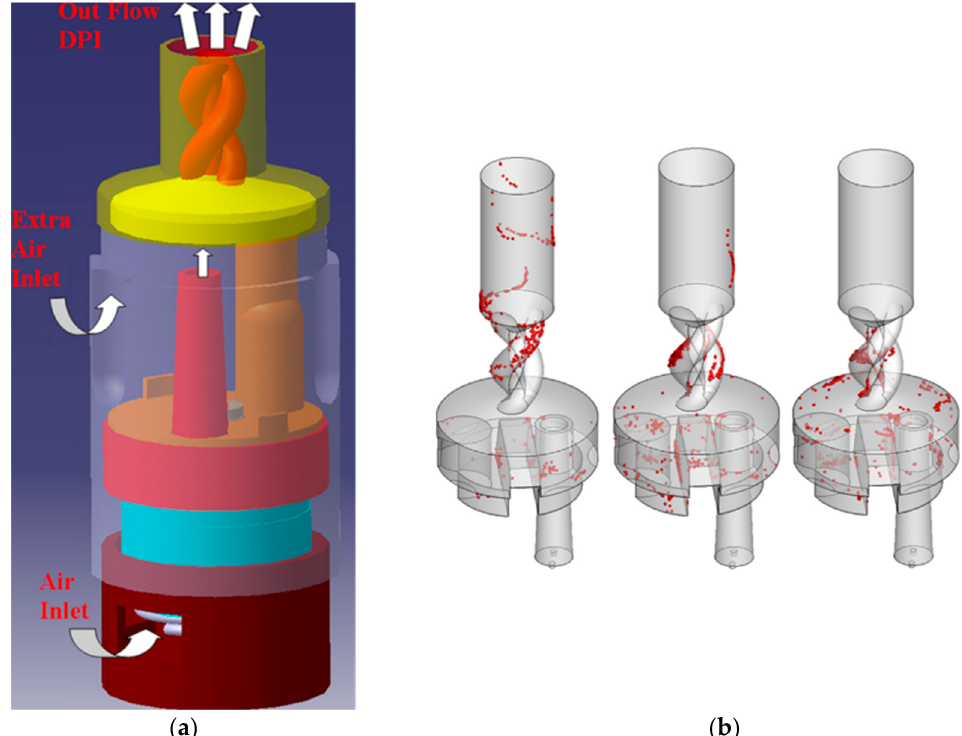
Figure 3. Schematic of a multidose dry powder inhaler ( a ) and calculated particle deposition (particle sizes from left to right are 1 µm, 2 µm and 5 µm, respectively) in the device ( b ) via a simple particle trajectory modelling. Reproduced with permission from [13], Elsevier, 2013.